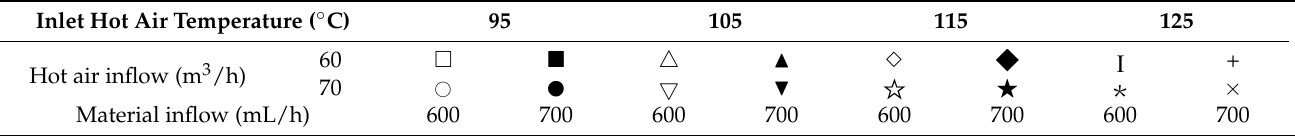
Table 1. Test variable group setting and representative pattern.